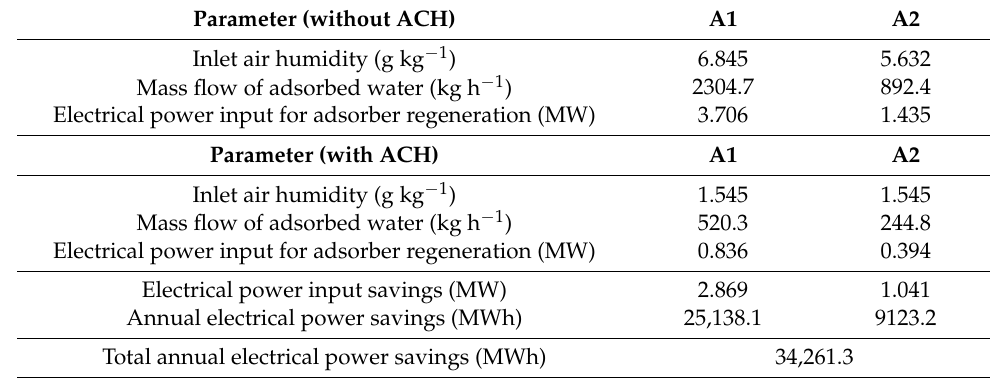
Table A13. Comparison of power consumption for adsorber regeneration in basic model (without ACH) and in the model with ACH.